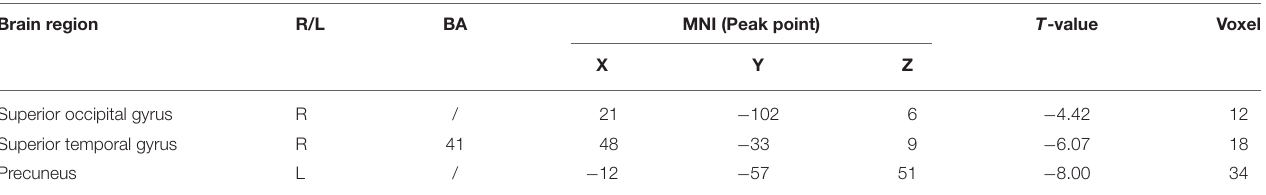
R, right; L, left; MNI, Montreal Neurological Institute. p < 0.001,